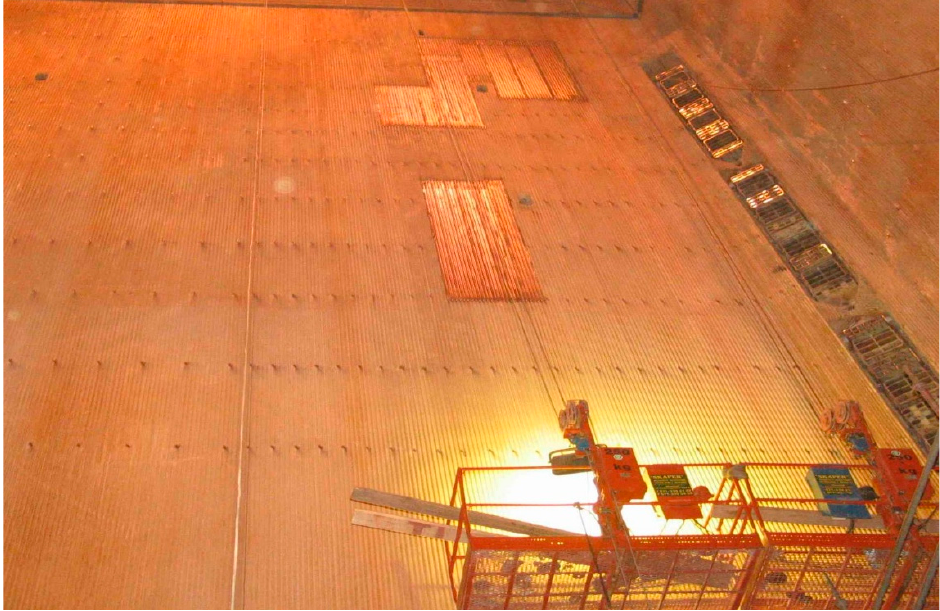
Figure 1. Boiler interior, showing scaffolding and the replaced screen fragments.